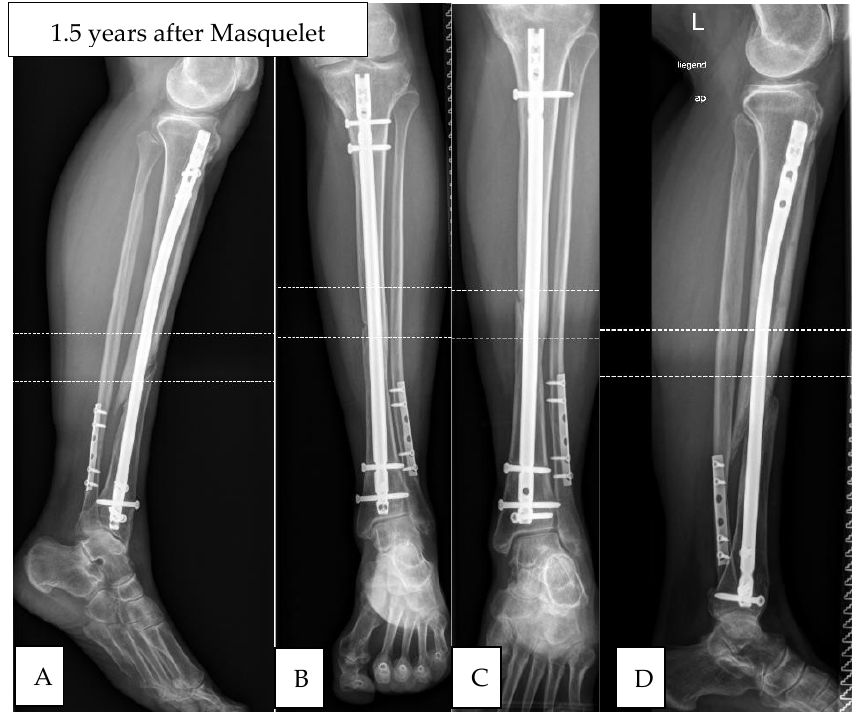
Figure 3. Atrophic tibial non-union (non- responder) initially treated with tibial nail, re-reamed and nailed according to diamond-concept, no consolidation at 12 months post-op. ( A ) lateral view pre-op; (B) ap-view pre-op; (C) ap-view post-op; (D) lateral view post-op.